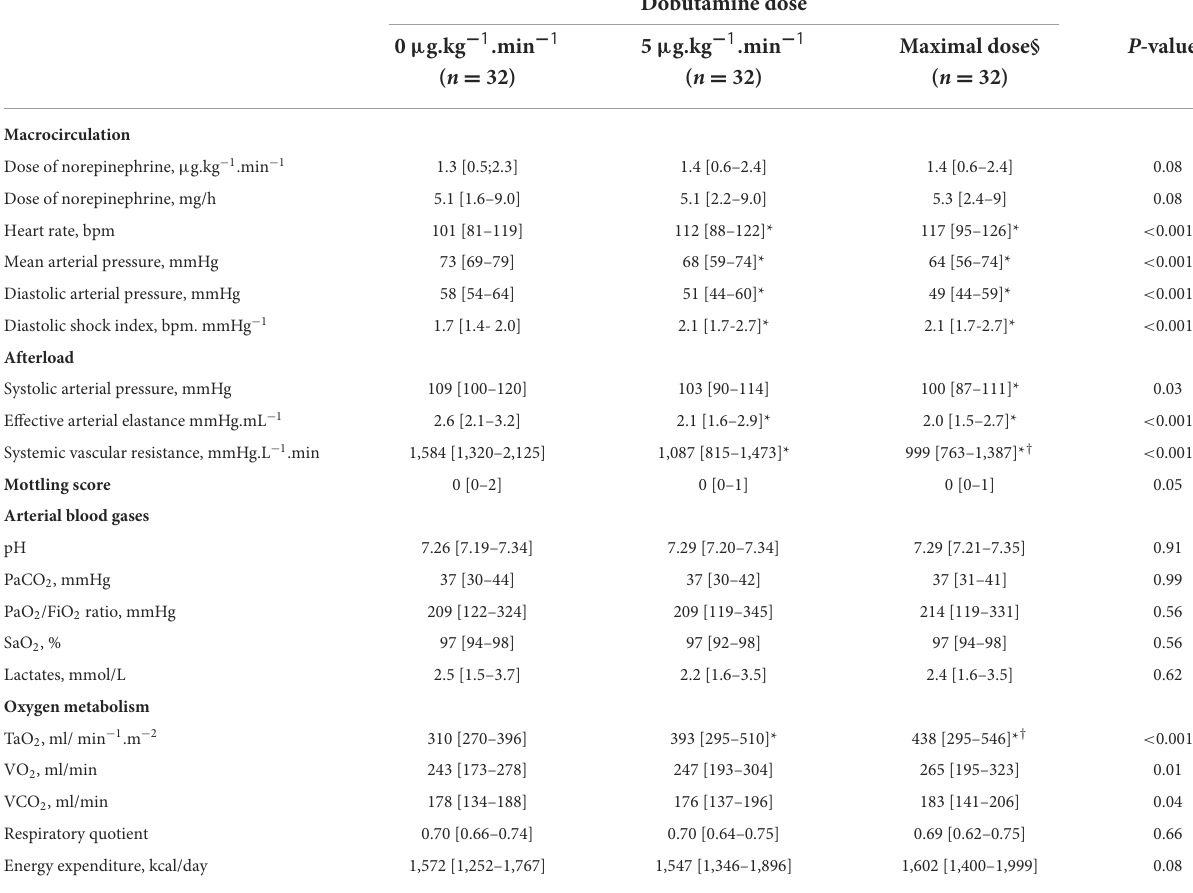
TABLE 2 Hemodynamic and metabolic response during dobutamine titration in patients with shock and septic myocardial